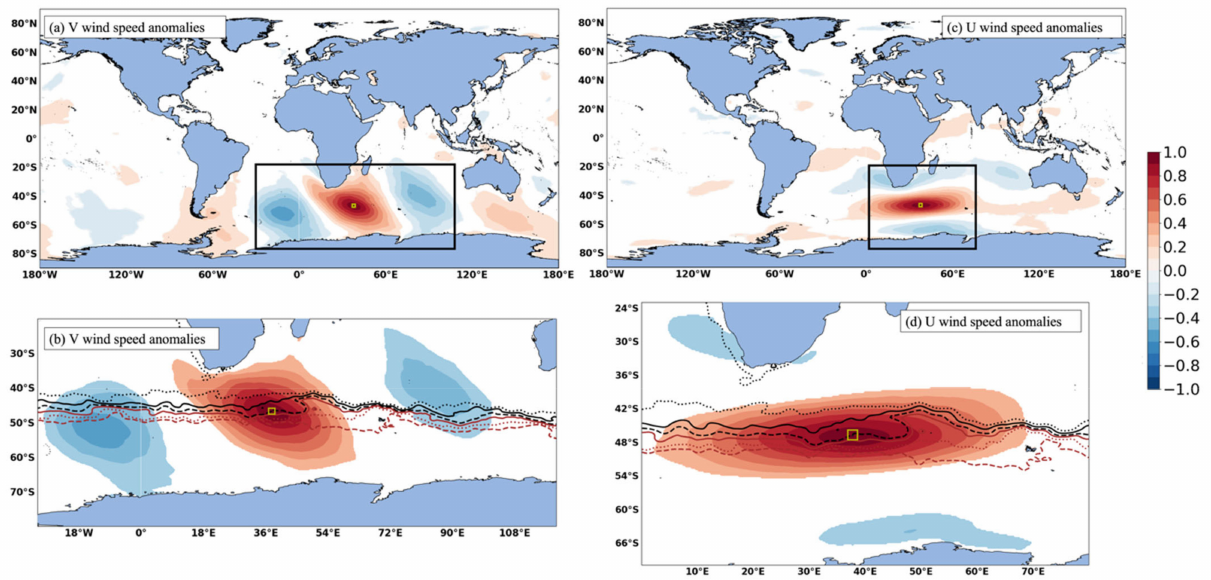
Figure 12. Maps of the significant correlation ( p -value < 0.05) between ( a ) meridional wind speed anomalies at the Prince Edward Islands (PEIs) and the meridional wind speed anomalies across the global ocean, ( c ) zonal wind speed anomalies at the PEIs and across the global ocean. The black box indicates the zoomed region in panels b and d. The zoomed maps show the regions of strong correlation ( − 0.3 < R > 0.3) for ( b ) meridional wind speed anomalies, and ( d ) zonal wind speed anomalies around the PEIs. The yellow box indicates the 2 ◦ × 2 ◦ area around the PEIs within which data were averaged for time series